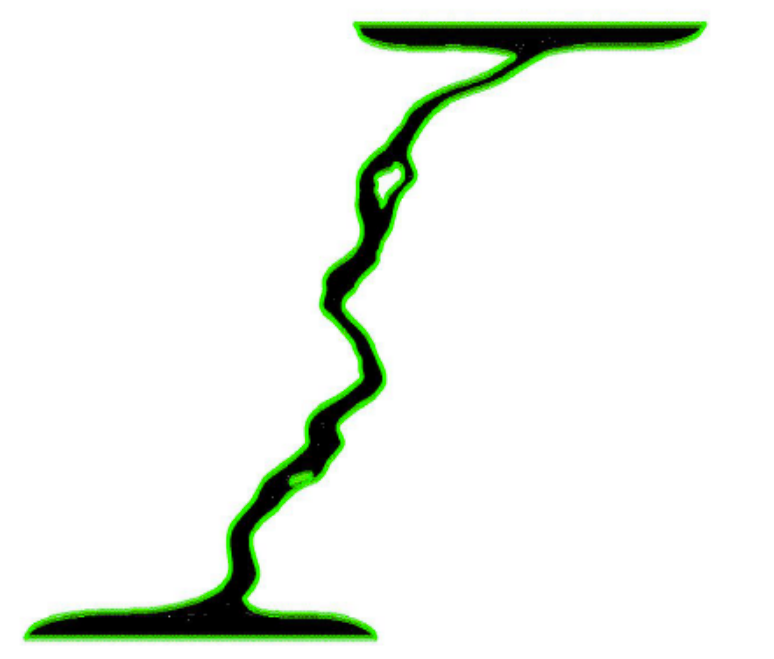
Figure 9. Grid used for our simulations.